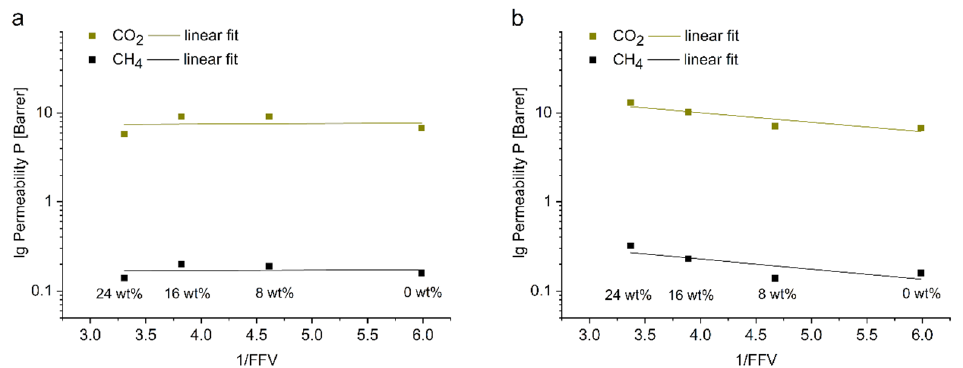
Figure 9. Lg permeability versus 1/FFV for 0 to 24 wt% ( a ) HHU-COF-1 and ( b ) HHU-COF-2 as dispersed phases in Matrimid MMMs.